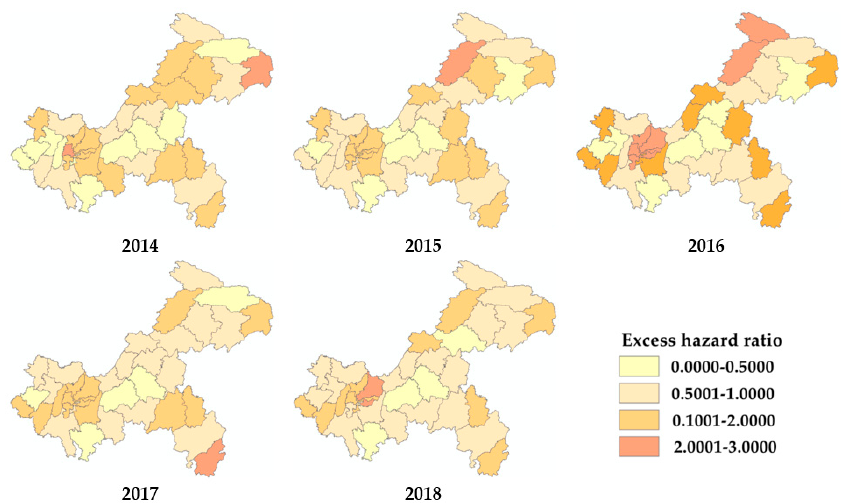
Figure 3. Excess hazard maps of varicella in Chongqing from 2014 to 2018.